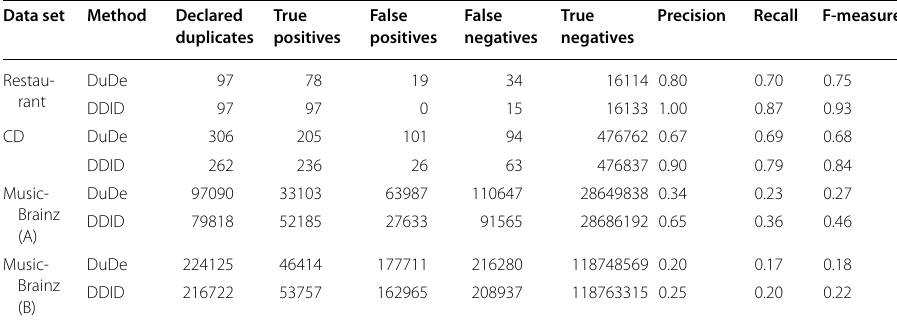
Table 2 Experiment results Data set